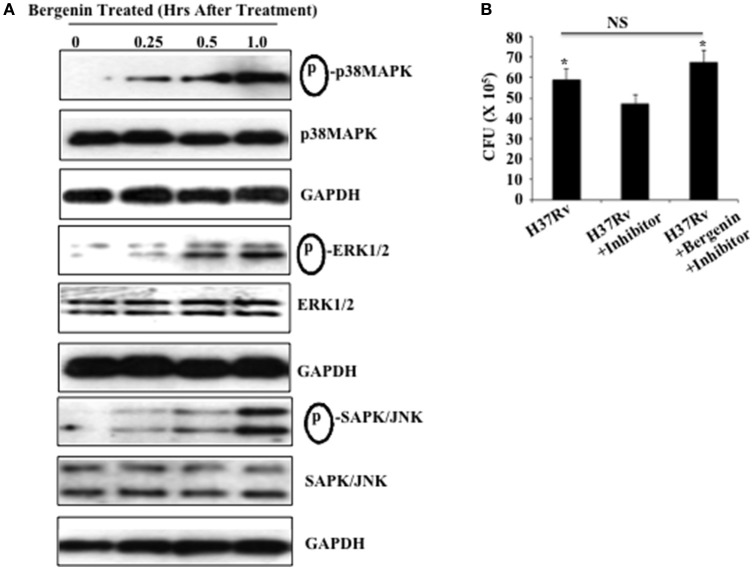
Bergenin treatment activates the MAPK pathway. (A) Peritoneal macrophages were untreated or treated with 50-μg/ml bergenin for different time periods. Phosphorylation of p38 MAPK, ERK1/2, and SAPK/JNK was assessed in whole cell lysate of bergenin-treated or untreated macrophages by Western blot. (B) Bacterial burden in the macrophages after treatment with MEK-1/2 inhibitor (U0126 from Cell Signaling Technologies). We isolated peritoneal macrophages, treated these cells with a MEK-1/2 inhibitor (20 μM) overnight, followed by infection with H37Rv and treatment with or without bergenin. Forty-eight hours later we harvested the cells for CFU assay, which revealed that treatment with bergenin was unable to reduce the bacterial burden in the presence of the MEK-1/2 inhibitor. The results shown here are representative of three independent experiments. *Indicates significant for p-value.